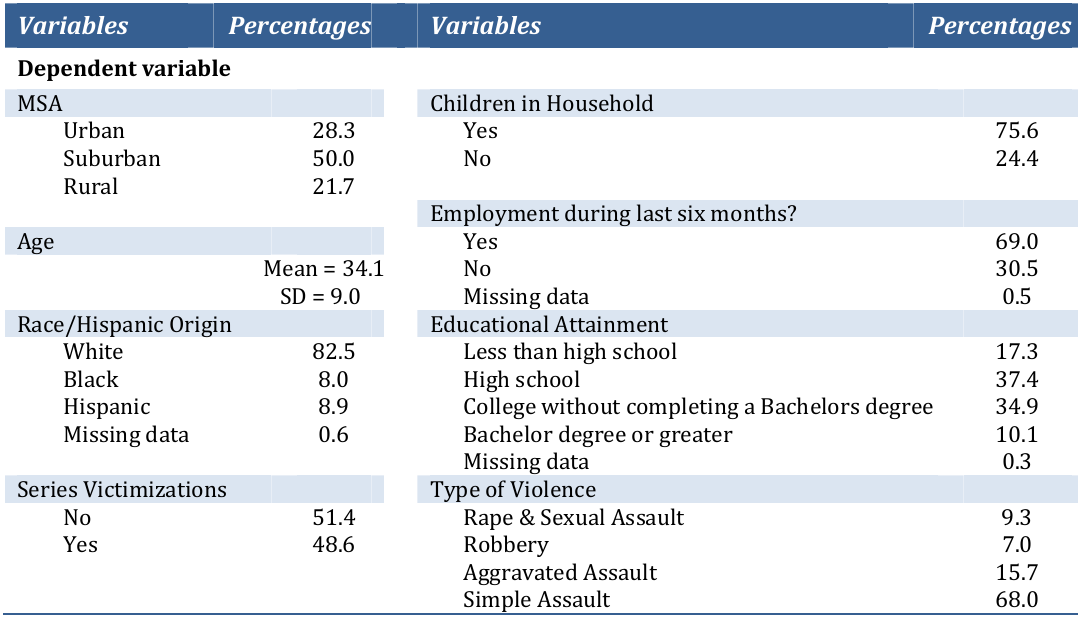
Table 1: Descriptives – age 16+; female victims